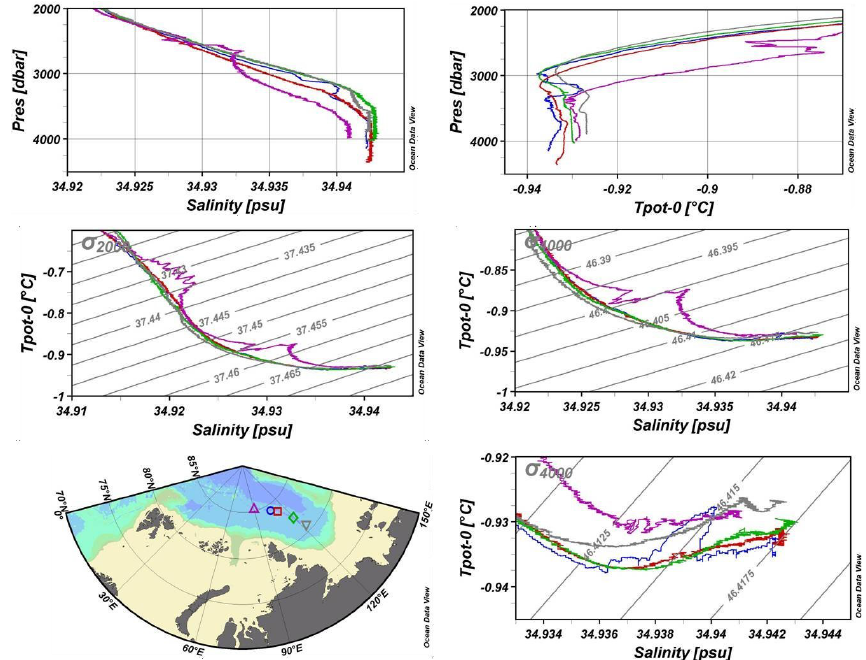
Fig. 20 . Profiles of salinity and potential temperature, and θS curves shown with different blow-up levels from SPACE stations taken above the Gakkel Ridge. The simple deep water structure found in the basins is here disrupted by several different maxima and minima. A strong input of warmer and more saline water is found at 2700m (magenta station), and a smaller deep intrusion is seen between 3100m and 3300m (blue station). The cause of these maxima could be geothermal activity at the ridge.